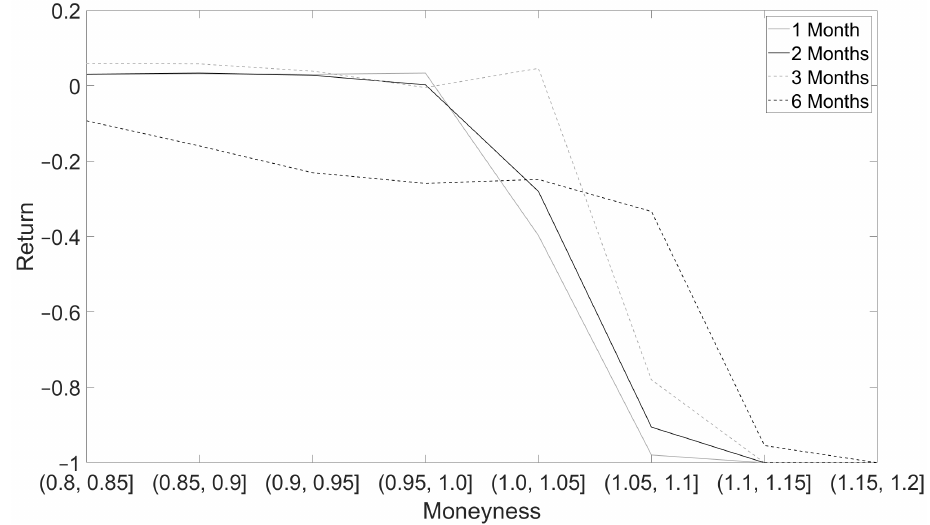
Figure A1. The average realized return of held-to-maturity call options on the S&P500 index, over the sample period from 2 January 2018 to 29 August 2018. 4 different maturity levels are encountered, and moneyness varies from 0.8 to